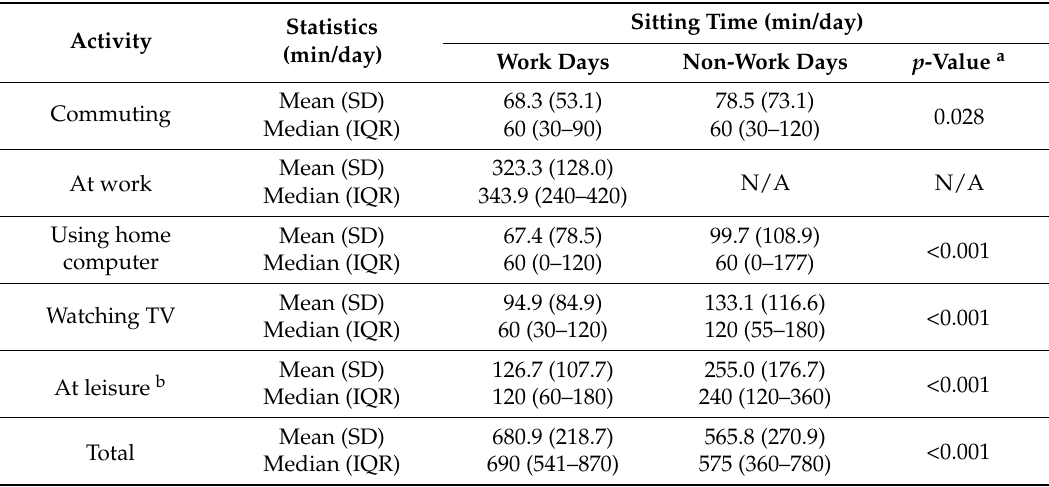
Table 2. Self-reported sitting time (min/day) during various activities on work days and non-work days ( n = 420).